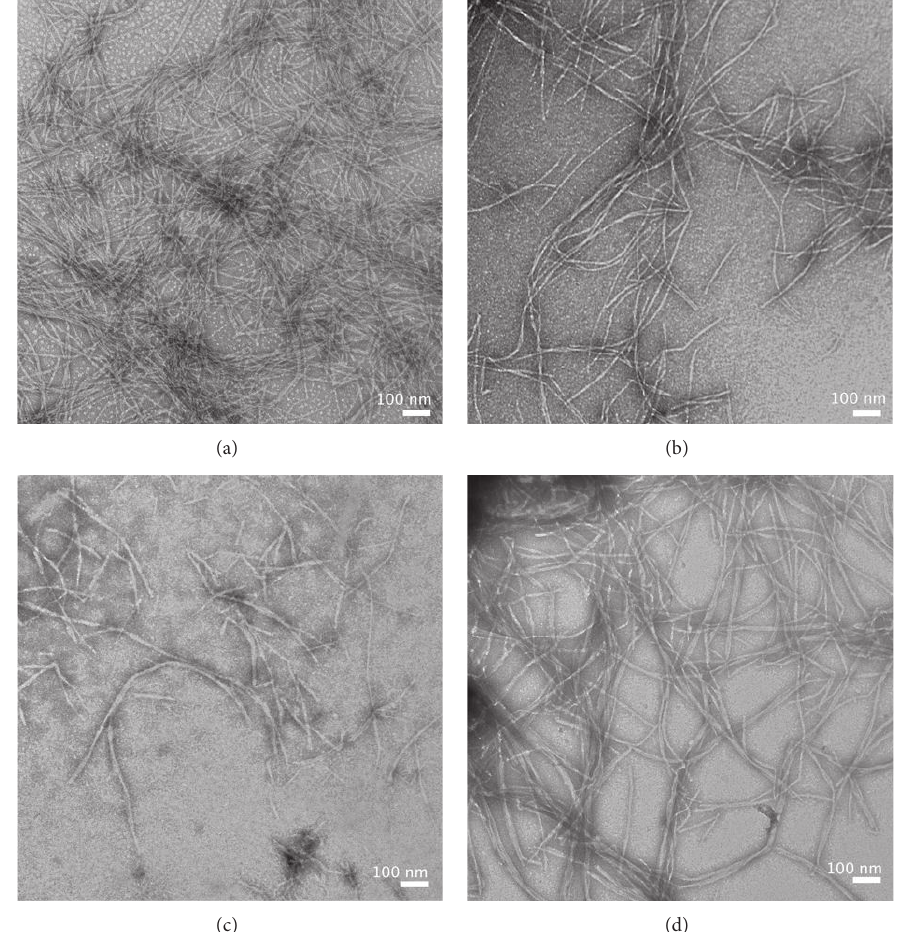
Figure 8: TEM images of fibrils formed from 80 𝜇 M WT amylin in the presence or absence of inhibitor peptides. (a) WT amylin alone, (b) with 160 𝜇 M Arg-1, (c) with 160 𝜇 M Arg-2, and (d) with 160 𝜇 M Mem-T. Aliquots were removed for TEM imaging 24 h after the fibrillization reactions were started. Reactions were carried out in 20 mM sodium phosphate (pH 7.4), 1% DMSO (v/v), at 37 ∘